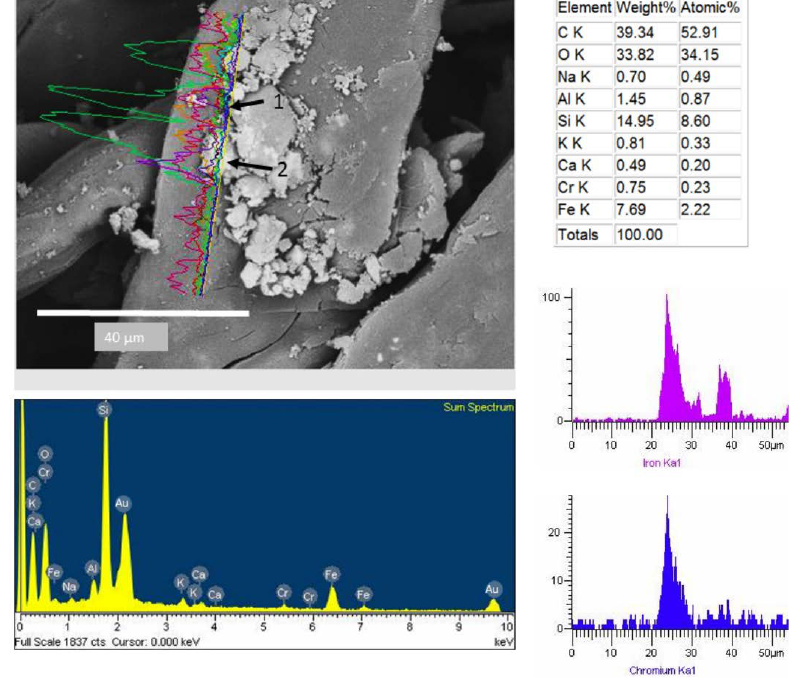
Figure 9. Metallic particles composed of (1) iron and (2) chromium.